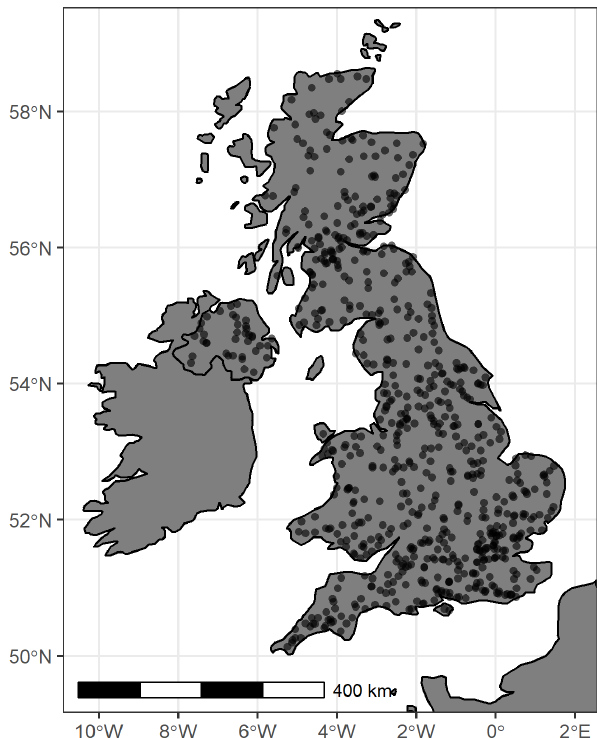
Figure 1. Locations of streamflow gauges used in this